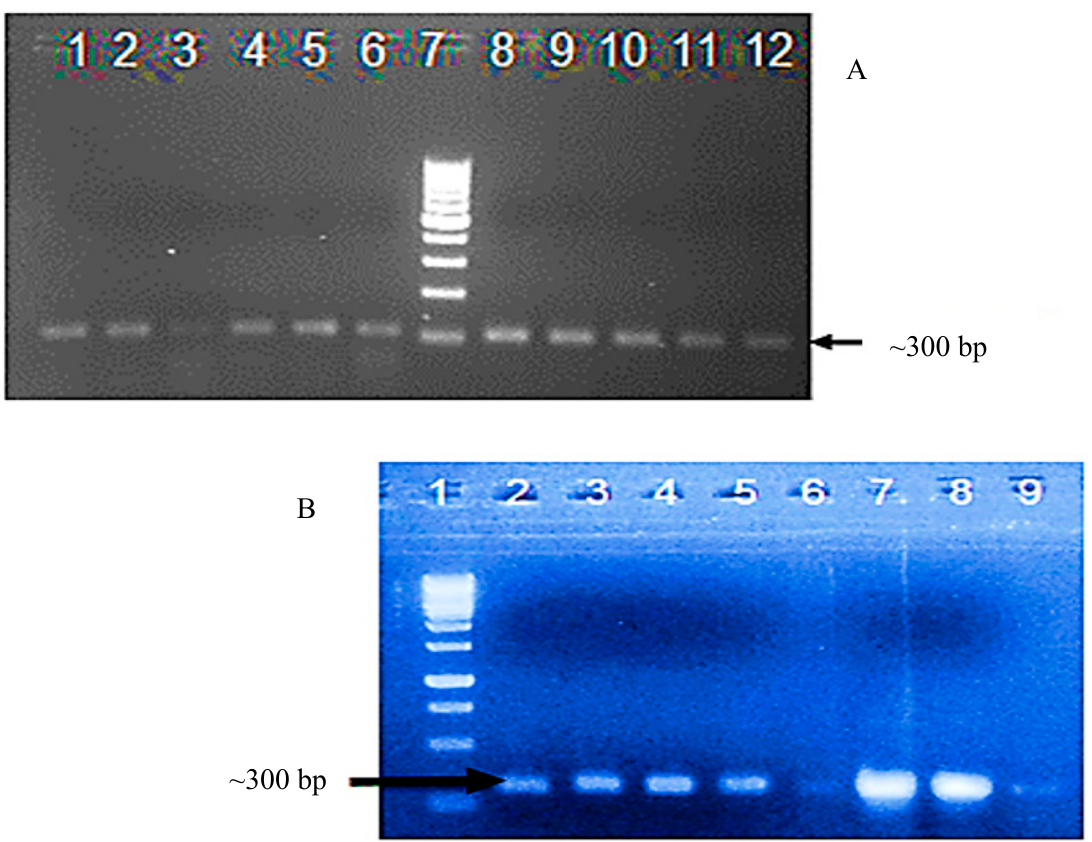
Figure 2. ( A ) Detection of transgene integration in the T 0 generation of transgenic cotton plants by polymerase chain reaction amplification using AC1 gene specific primers, which yielded the expected size ~300 bpamplicon. Lanes 1–5: PCR amplification from transgenic cotton plants; Lane 6 and 8: positive controls (full-length CLCuKoV-Bur DNA-A clone); Lane 7: 1kb ladder; and Lanes 9–12: PCR products amplified from transgenic cotton plants. ( B ) Detection of transgene